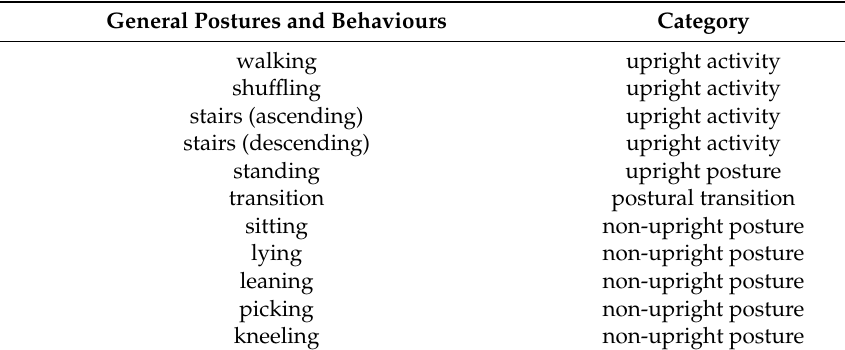
Table 2. The general purpose categories.